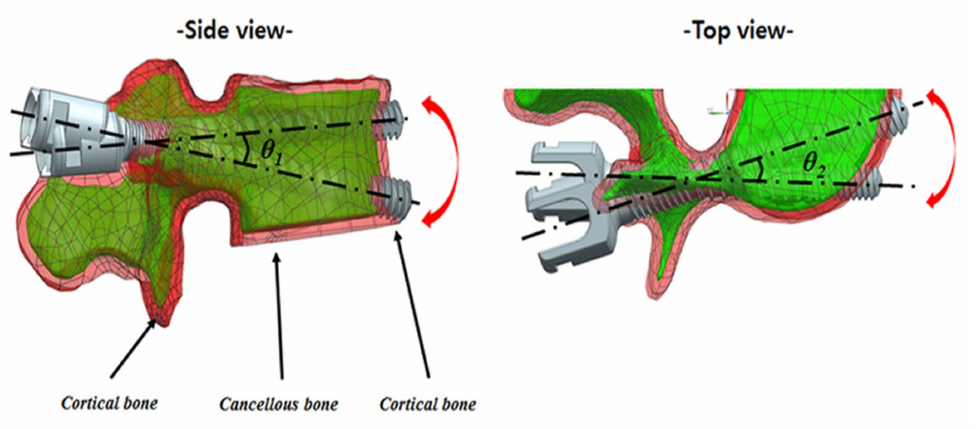
Figure 3. Simulation of screw insertion using an anterior cortex purchase